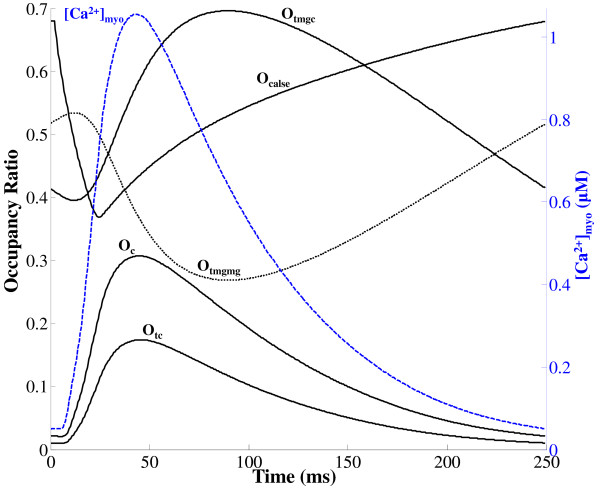
Occupancy of Ca2+ buffers. Figure 22: Contributions of fractional occupancy of Ca2+ buffers in SR and cytoplasm. Transfer from Oc and Otc to Otmgc occurs as a result of the pulse stimulation. Otmgmg is shown as a dotted line as it does not reflect Ca2+ binding. The corresponding [Ca2+]myo is overlayed (note the different axis)